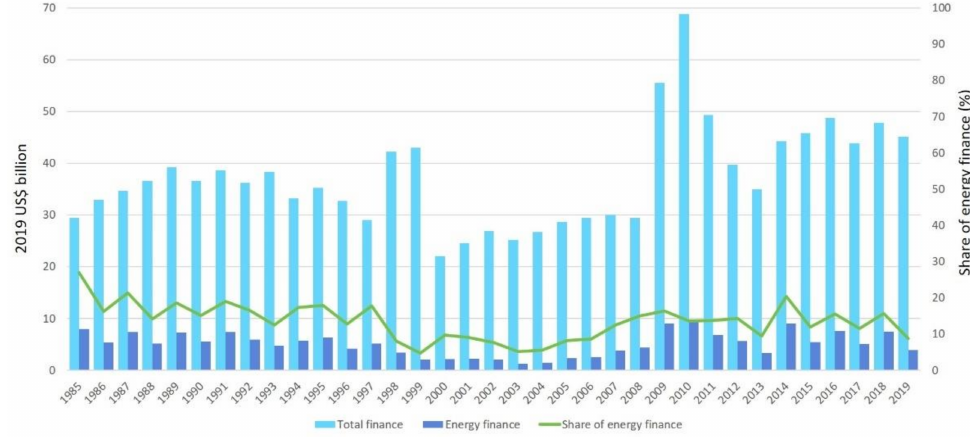
Figure 5. The World Bank’s total development finance and energy finance (1985–2019). Source: authors’ illustration based on